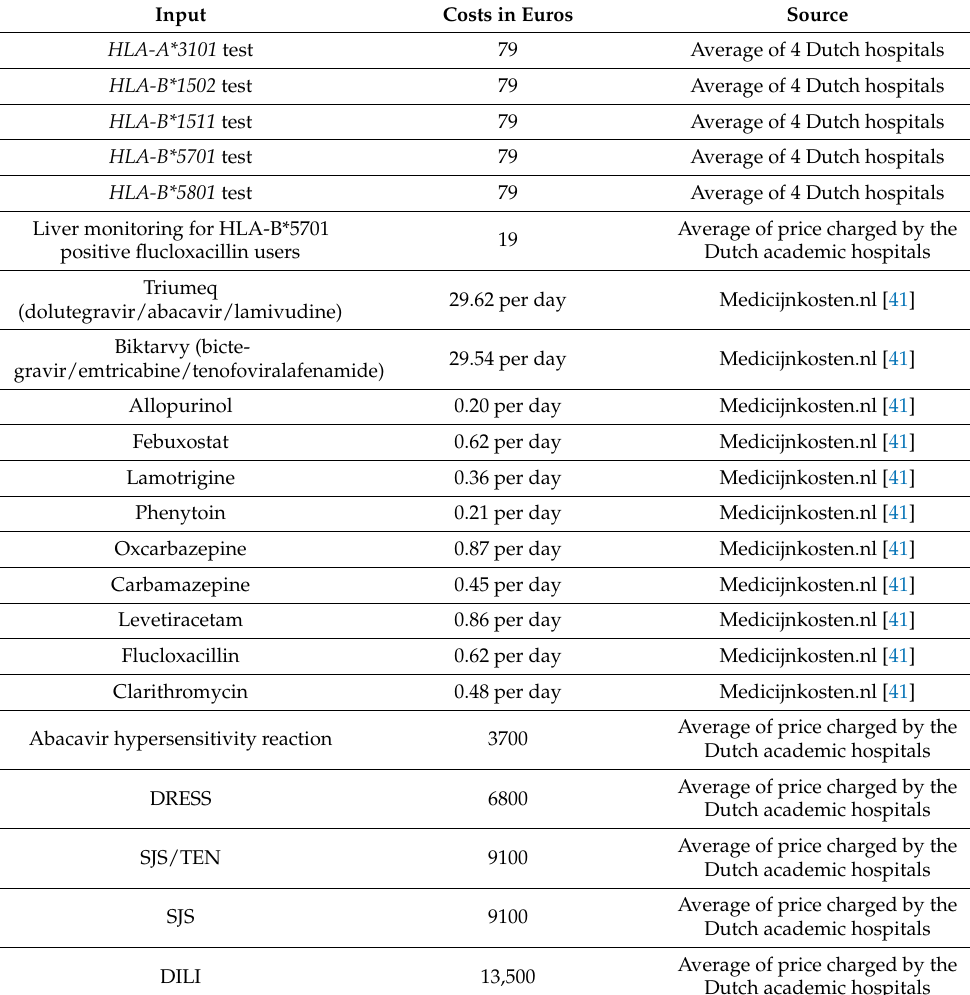
Table 7. Model inputs for the healthcare